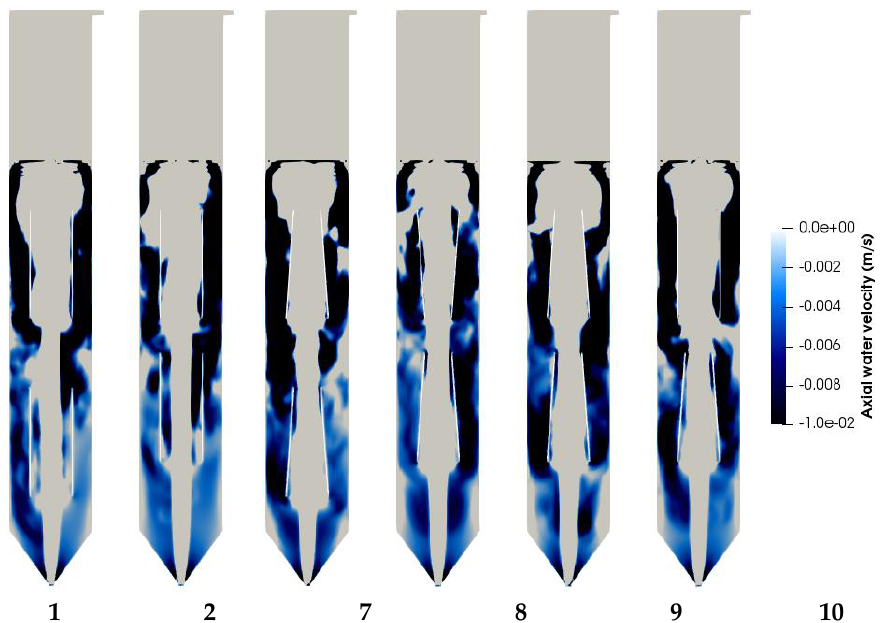
Figure 12. Filtered downcomer velocity neglecting the riser flow of geometries 1, 2, 7, 8, 9 and 10.